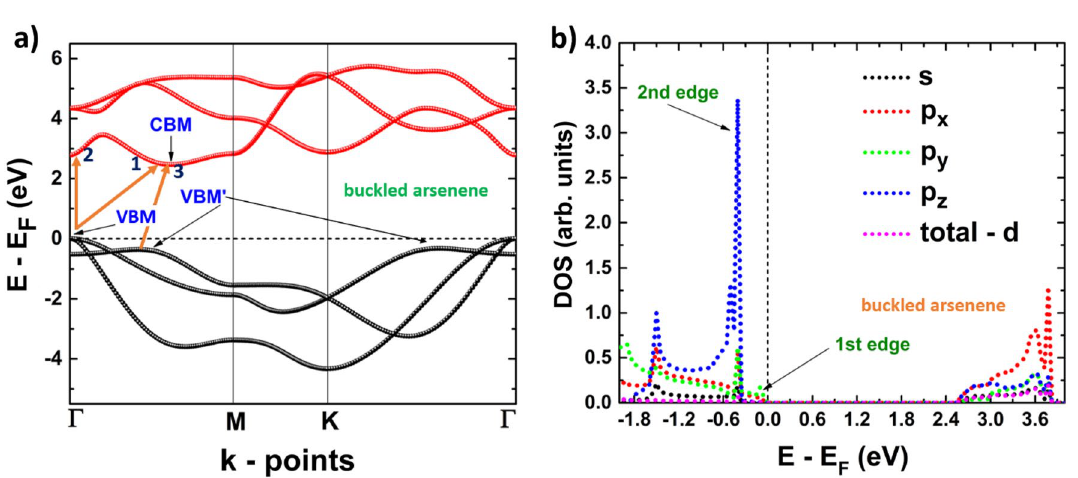
Figure 6. ( a ) Band structure; 1, 2 and 3 refers to possible electronic transitions. ( b ) projected density of states of buckled